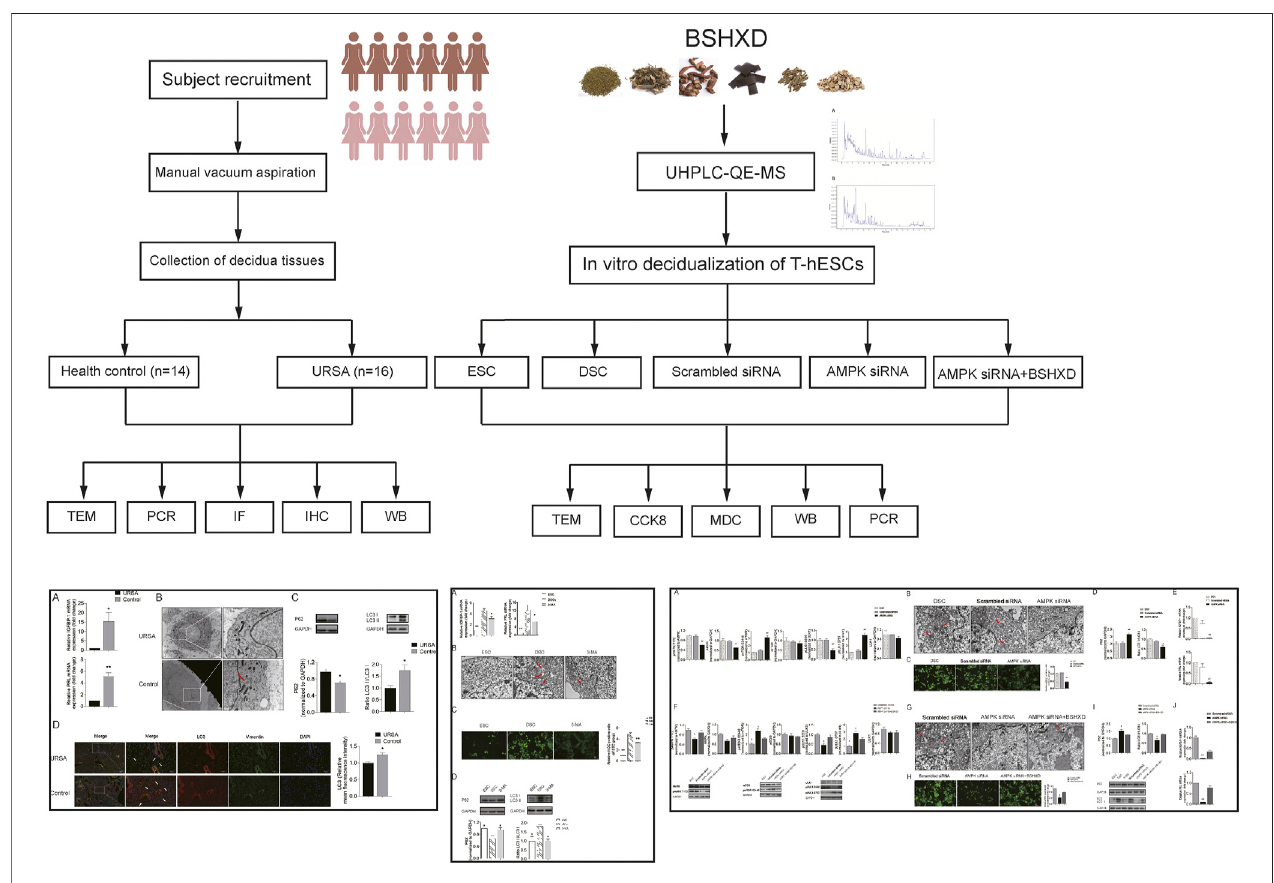
FIGURE 1 | The detailed technical strategy of the current study.